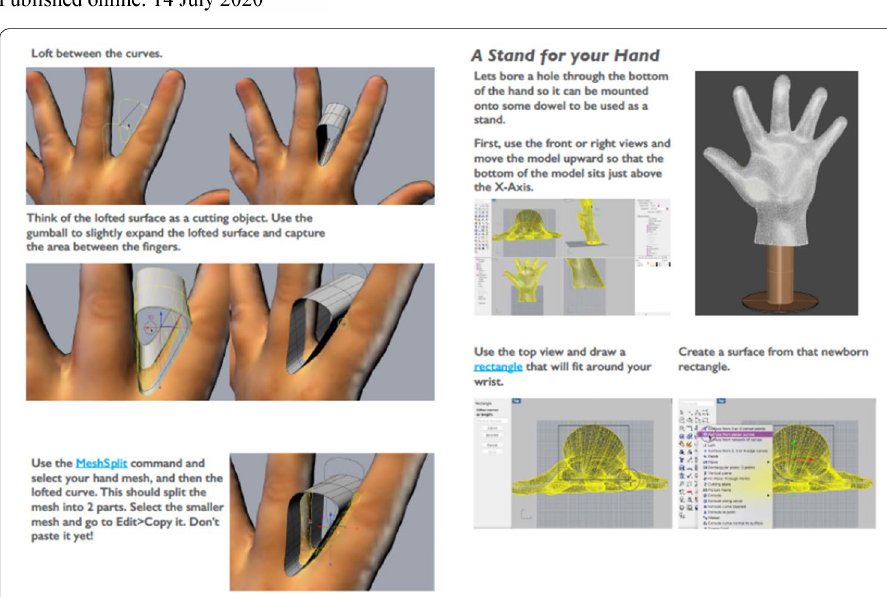
Fig. 4 Example of 3D hand scan processing in Rhino software and Stand Development (Sokolowski and Corr